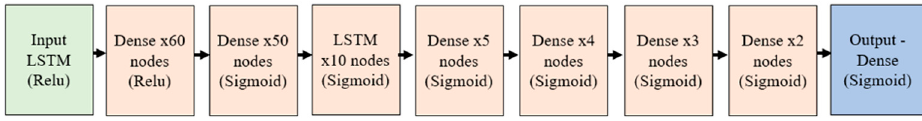
Figure 9. LSTM model for text-based datasets.